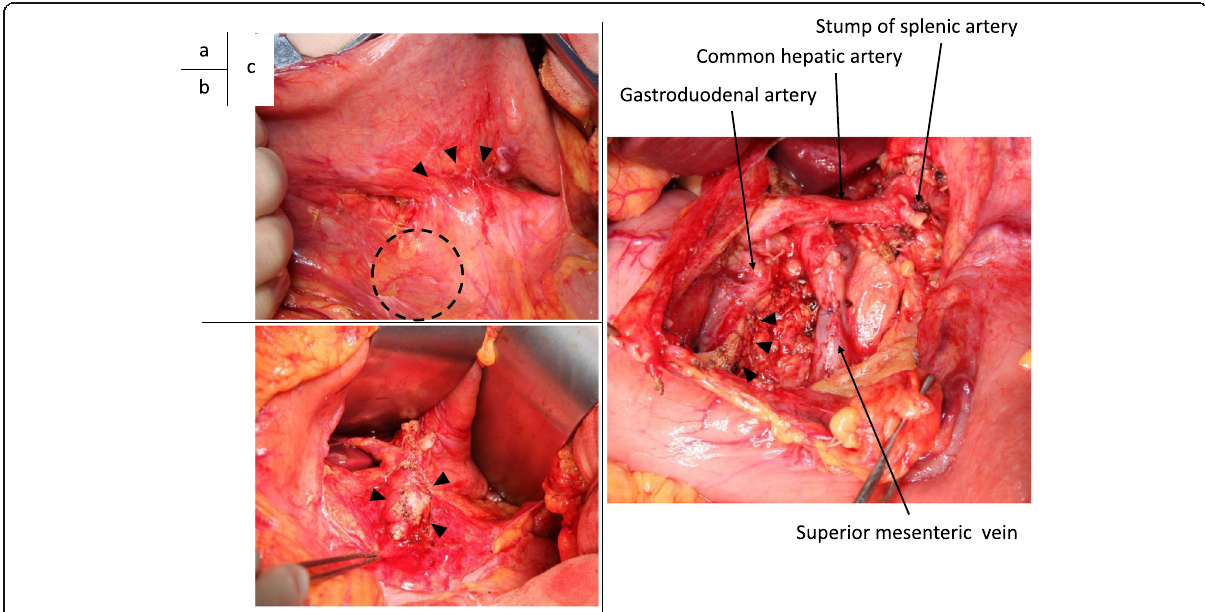
Fig. 2 Intraoperative findings. a At laparotomy, the tumor was found within the pancreatic body (dashed circle). No serosal or vascular invasion was present. On the tail side of the tumor, severe adhesion was observed between the pancreas and the stomach (arrowhead). b Frontal view of the pancreas after partial resection of the serosa of the stomach. The intraoperative frozen section examination confirmed the lack of any cancer cells on the detached surface (arrowhead). c The pancreas was divided at the left edge of the gastroduodenal artery (arrowhead). Distal pancreatectomy with radical lymphadenectomy and splenectomy was then completed